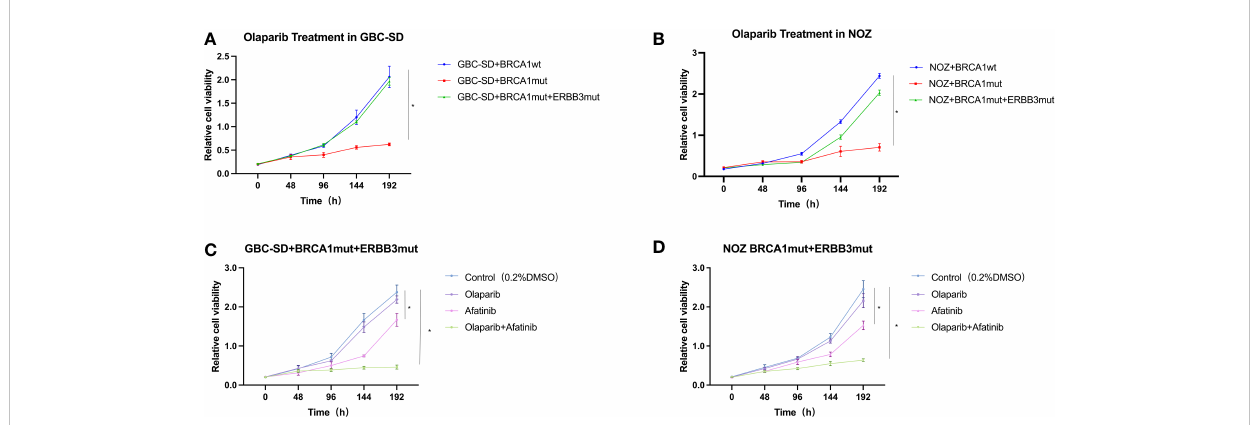
FIGURE 3 Cell viability of GBC-SD and NOZ cells expressing BRCA1 p.Arg1325Lys and ERBB3 p.Gly337Arg mutation. (A) GBC-SD cells expressing BRCA1 wild type (wt) or BRCA1 p.Arg1325Lys (mut) or both BRCA1 p.Arg1325Lys (mut) and ERBB3 p.Gly337Arg (mut) responded to olaparib (20 m M) over 192 h. (B) NOZ cells expressing both BRCA1 and ERBB3 wt or BRCA1 p.Arg1325Lys and ERBB3 p.Gly337Arg mutation responded to olaparib (20 m M) and afatinib (10 m M). (C) GBC-SD cells expressing both BRCA1 p.Arg1325Lys and ERBB3 p.Gly337Arg mutation responded to olaparib and afatinib. (D) NOZ cells expressing both BRCA1 p.Arg1325Lys and ERBB3 p.Gly337Arg mutation responded to olaparib and